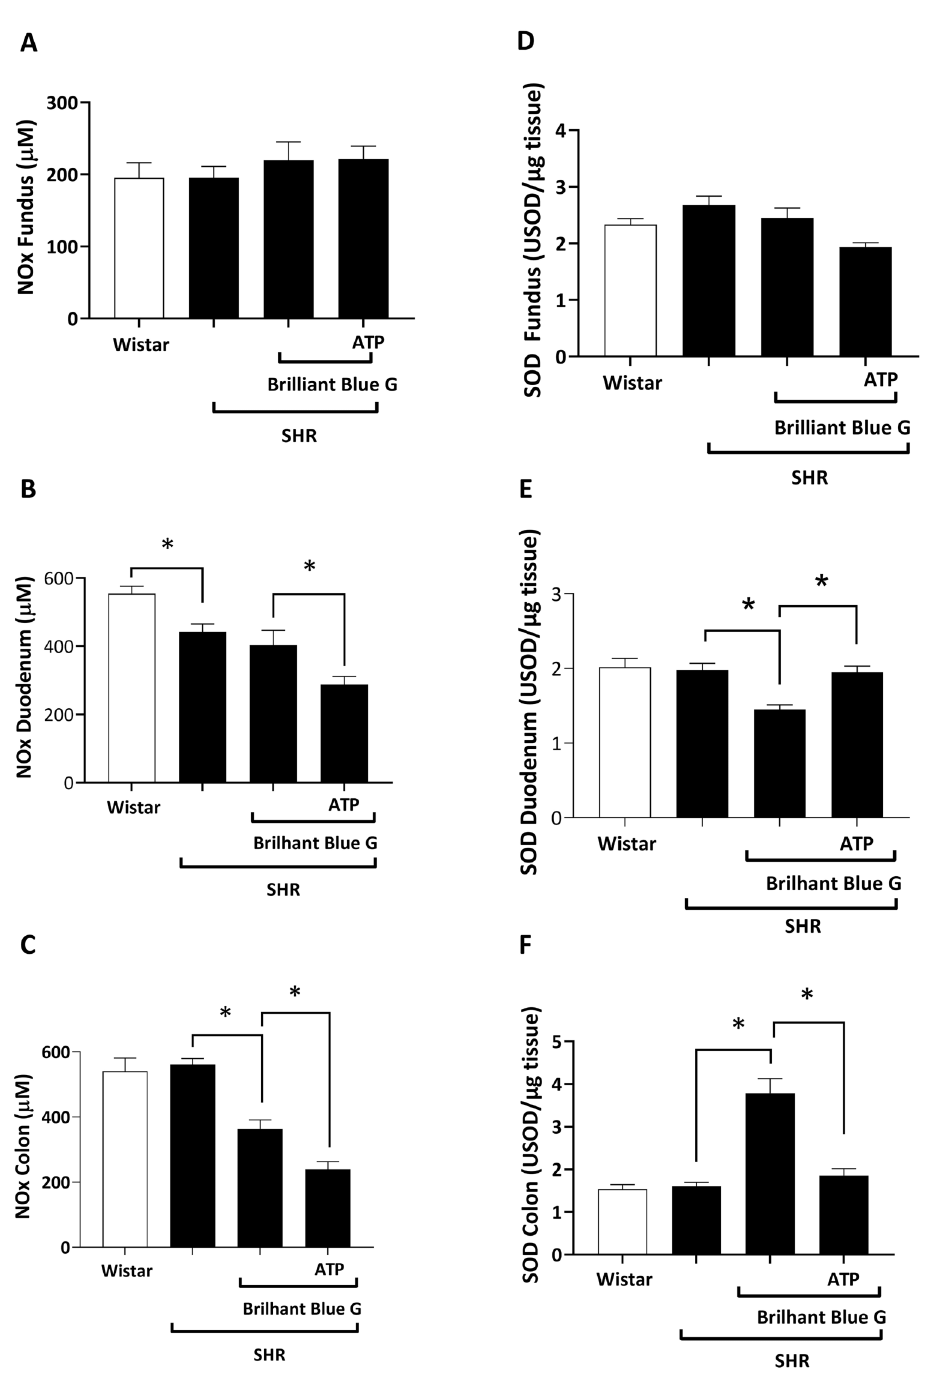
Figure 5. Nitrite/nitrate (NOx) concentrations in the gastric fundus ( A ), duodenum ( B ), and colon ( C ) of Wistar rats vs spontaneously hypertensive rats (SHR), SHR treated with BBG, and SHR treated with BBG plus ATP. Superoxide dismutase (SOD) activity in the gastric fundus ( D ), duodenum ( E ), and colon ( F ) of Wistar rats vs SHR, SHR treated with BBG, and SHR treated with BBG plus ATP. Data are reported as means ± SE. *P o 0.05 (one-way ANOVA, followed by the Tukey test). BBG: Brilliant Blue G; ATP: adenosine triphosphate; USOD: units of